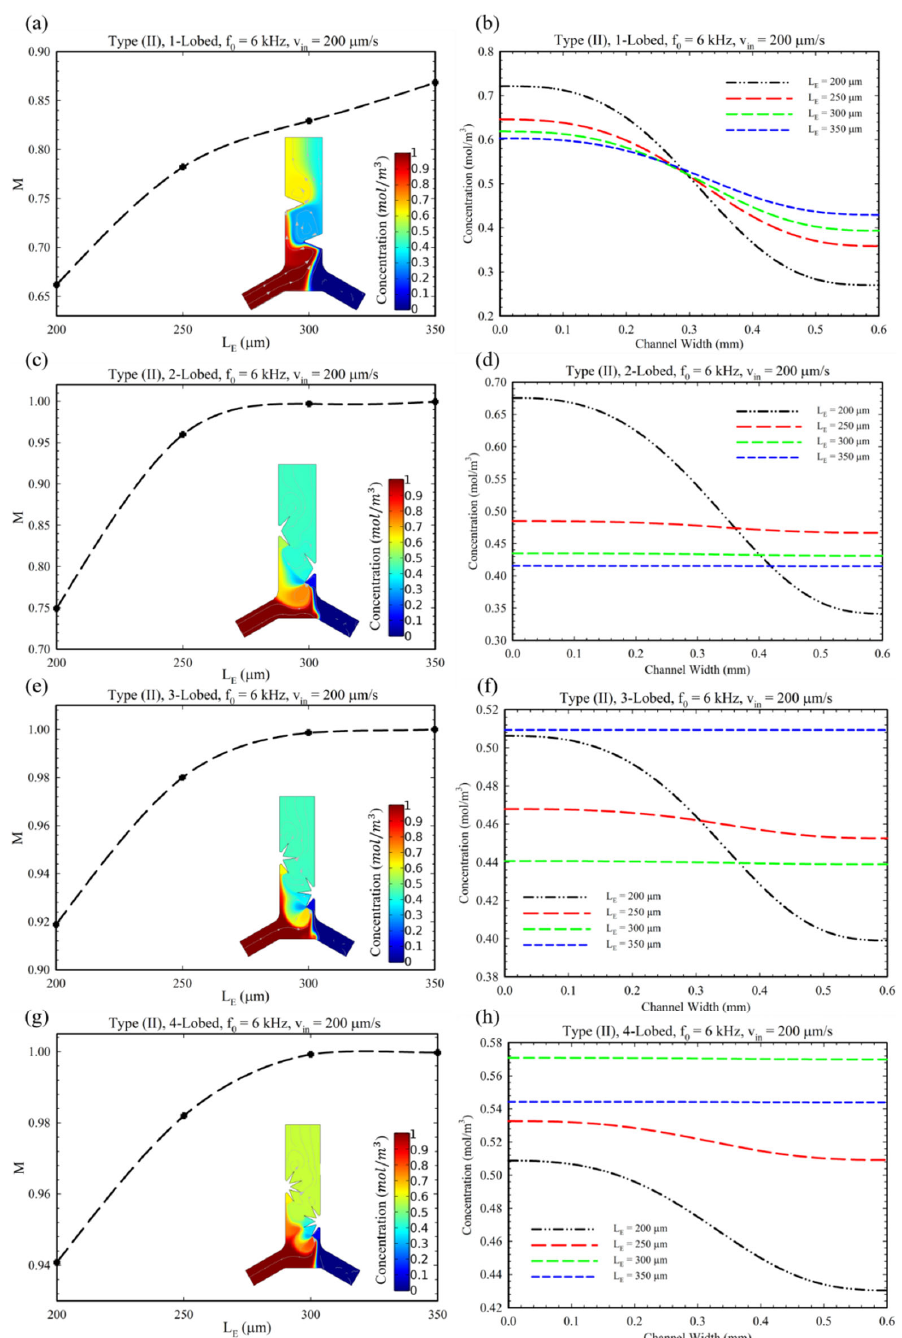
Figure 6. The diagram for analyzing the performance of microchannel Type II configuration having different multi-lobed structures: ( a , c , e , g ) the effect of length ( L E ) of lobes on MI. ( b , d , f , h ) The concentration profile of solute substance at the outlet cross-section for Type